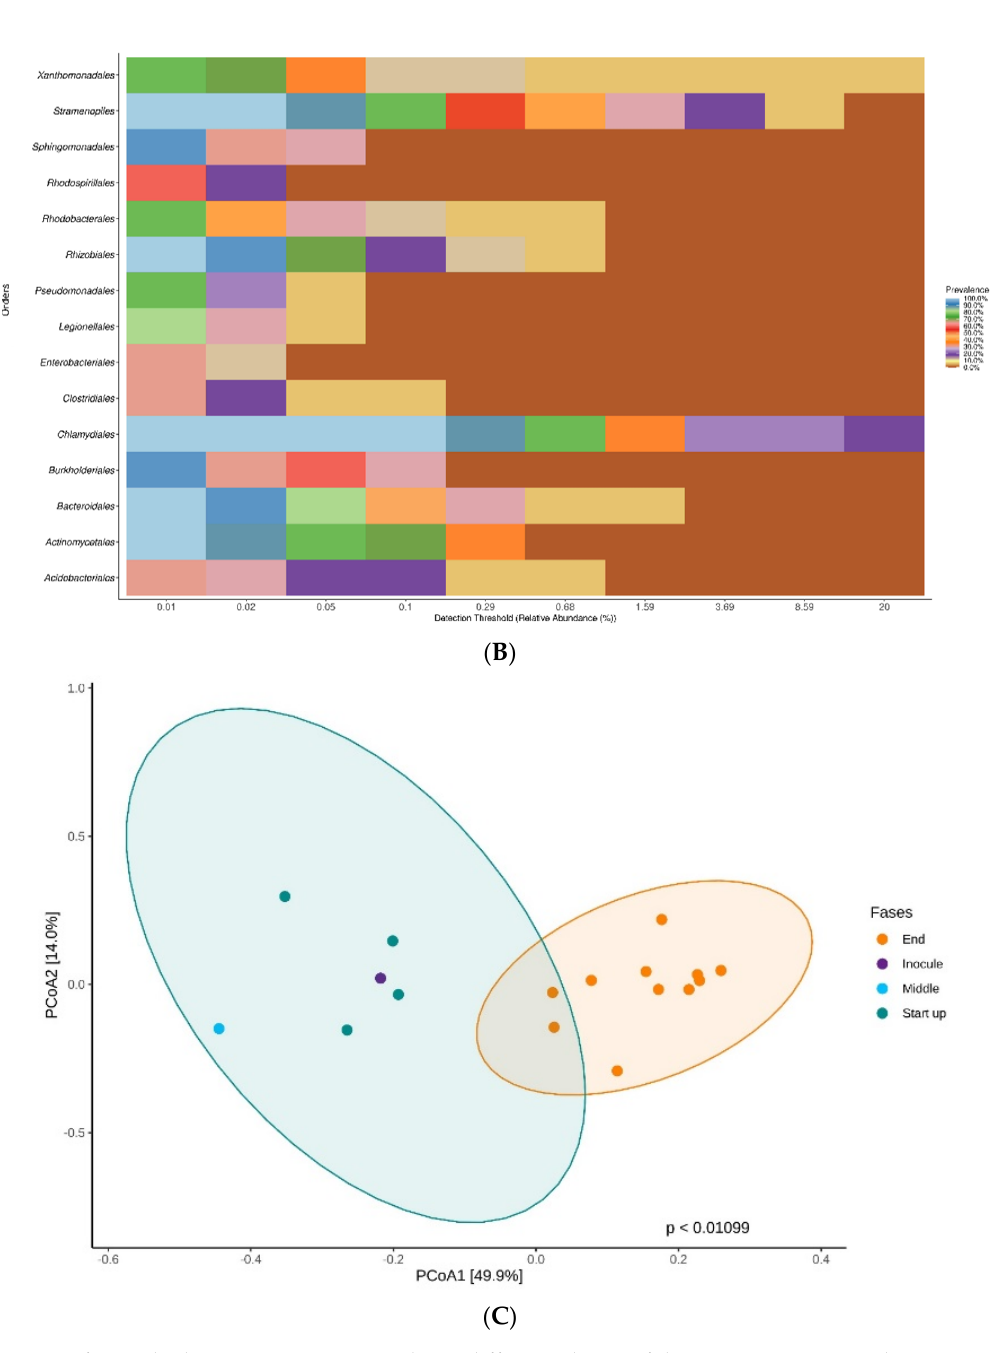
Figure 5 . Comparison of microbial communities in samples at different phases of the process. ( A ) Venn diagram reporting the shared OTUs among phases. ( B ) Core microbiome heatmap at the families level. ( C ) Principal coordinates analysis (PCoA) for inoculum, start up, middle and end phases.